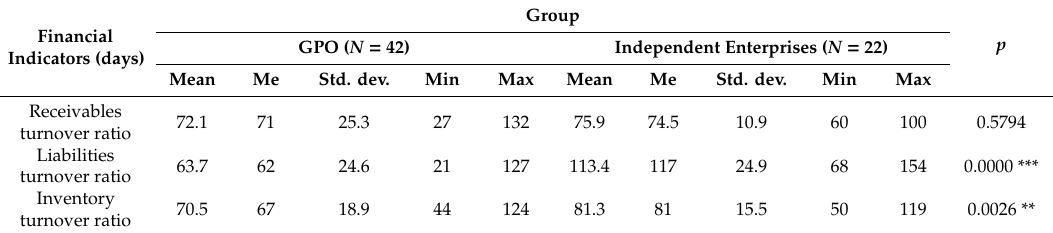
Table 6. Statistics on the distribution of financial indicators in both groups compared.